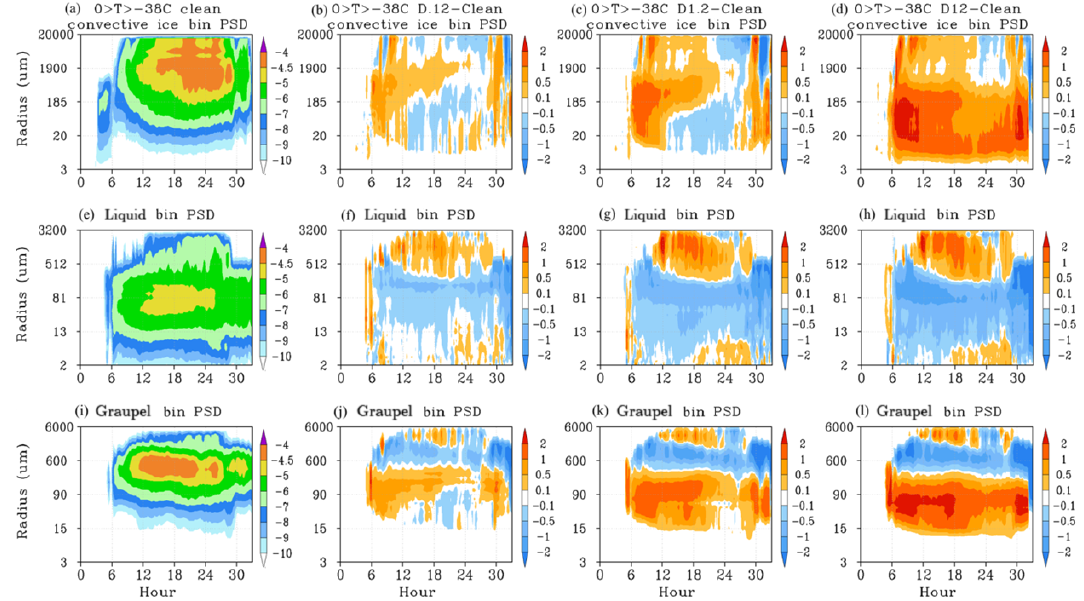
Figure 7. Time series and dust case minus Clean case difference plots of ice or snow bin particle size distribution (PSD; a–d ), liquid bin PSD (e–h) , and graupel bin PSD (i–l) ; averaged over the convective regime in the temperature range of − 5 to − 38 ◦ C. Contours represent log 10 values of bin population. Columns: Clean (a, e, i) , D.12 – Clean (b, f, j) , D1.2 – Clean (c, g, k) , and D12 – Clean (d, h, l)